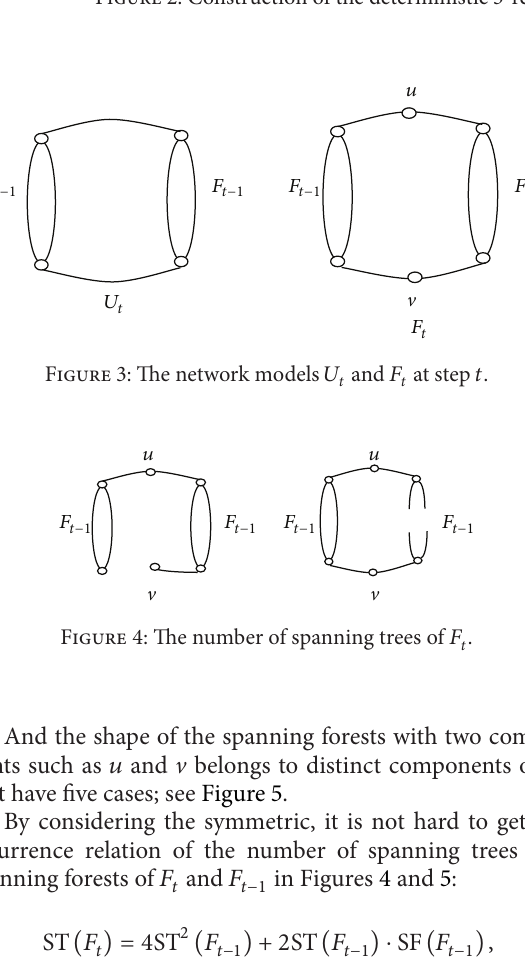
Figure 2: Construction of the deterministic 3-regular network 𝐹 𝑡 , showing three steps of the iterative progress.